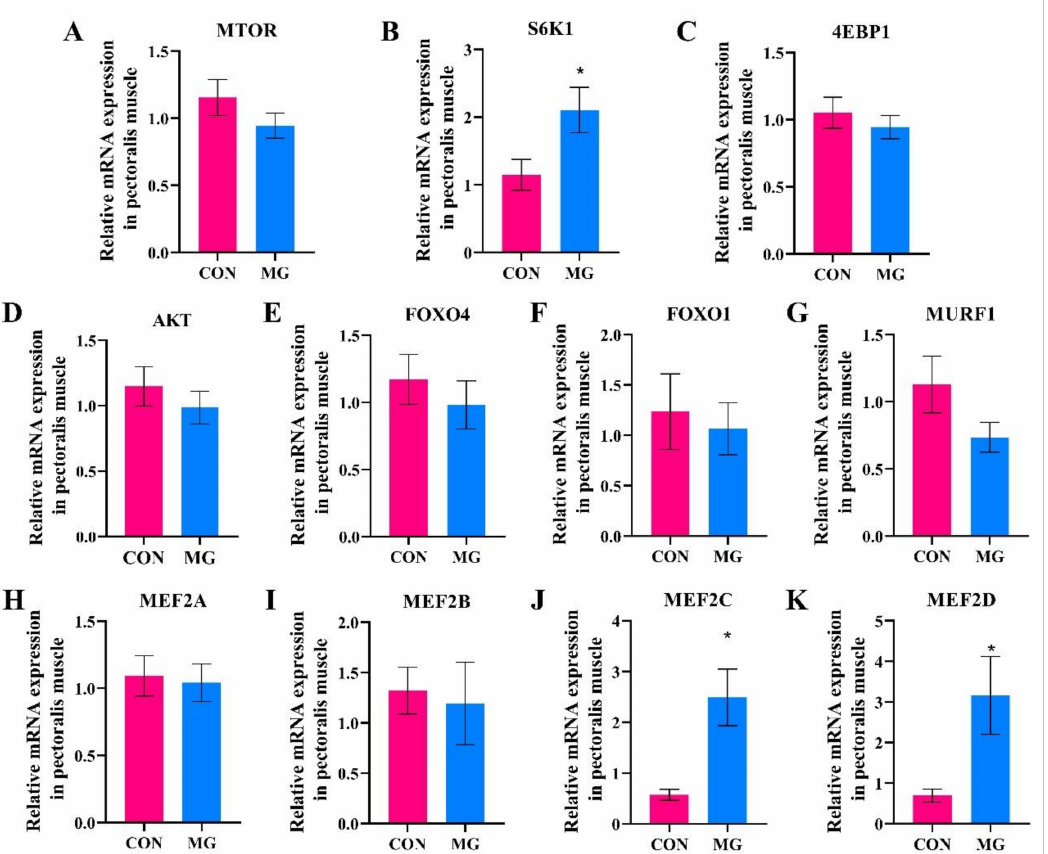
Figure 3. Changes in mRNA expression of muscle protein synthesis and myocyte differentiation with MG supplementation. ( A ), Mammalian target of rapamycin; ( B ), Ribosomal p70 S6 Kinase; ( C ), Eukaryotic translation initiation factor 4E-binding protein 1; ( D ), Serine/threonine protein kinase B; ( E ), Forkhead box O4; ( F ), Forkhead box protein O1; ( G ), Muscle RING-finger protein-1; ( H ), Myocyte enhancer factor 2A; ( I ), Myocyte enhancer factor 2B; ( J ), Myocyte enhancer factor 2C; ( K ), Myocyte enhancer factor 2D. Chicks fed a basal diet (the control group, CON) or a basal diet enriched with 300 mg/kg MG (MG). Data are shown as mean ± SD ( n = 12, * p <